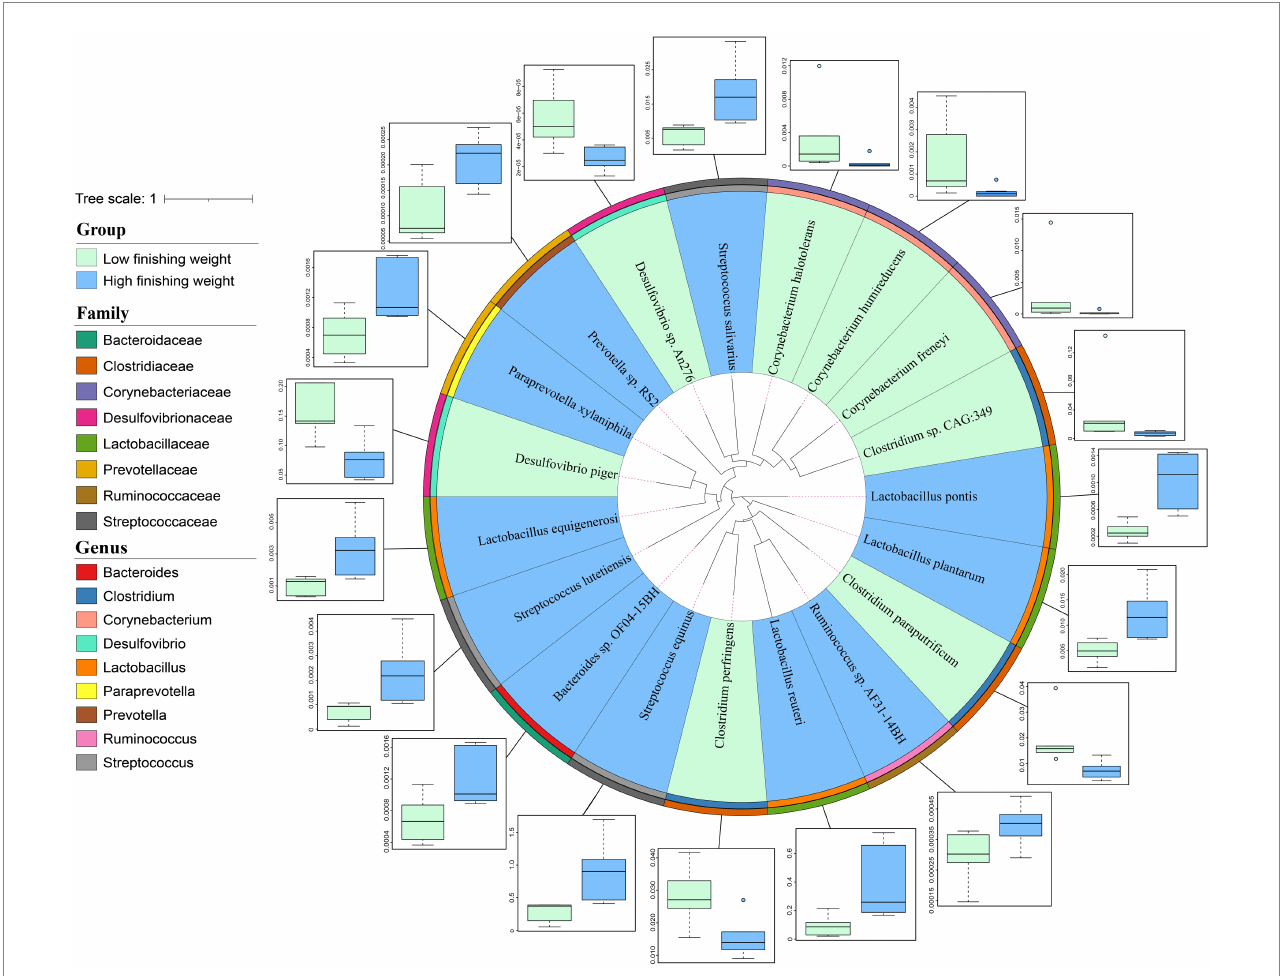
FIGURE 3 The phylogenetic relationships and abundance comparison of metagenomic species in low and high finishing weight pigs. The phylogenetic tree of species is displayed as the innermost layers. Labels with green and blue colors represent low and high finishing weight groups, respectively. The different color strips in the third and four layers, respectively, correspond to different genera and families as indicated by the color codes on the left. The outermost layer was the boxplot representing the abundance comparison of finishing weight associated species. The dots in the bar chart represent species